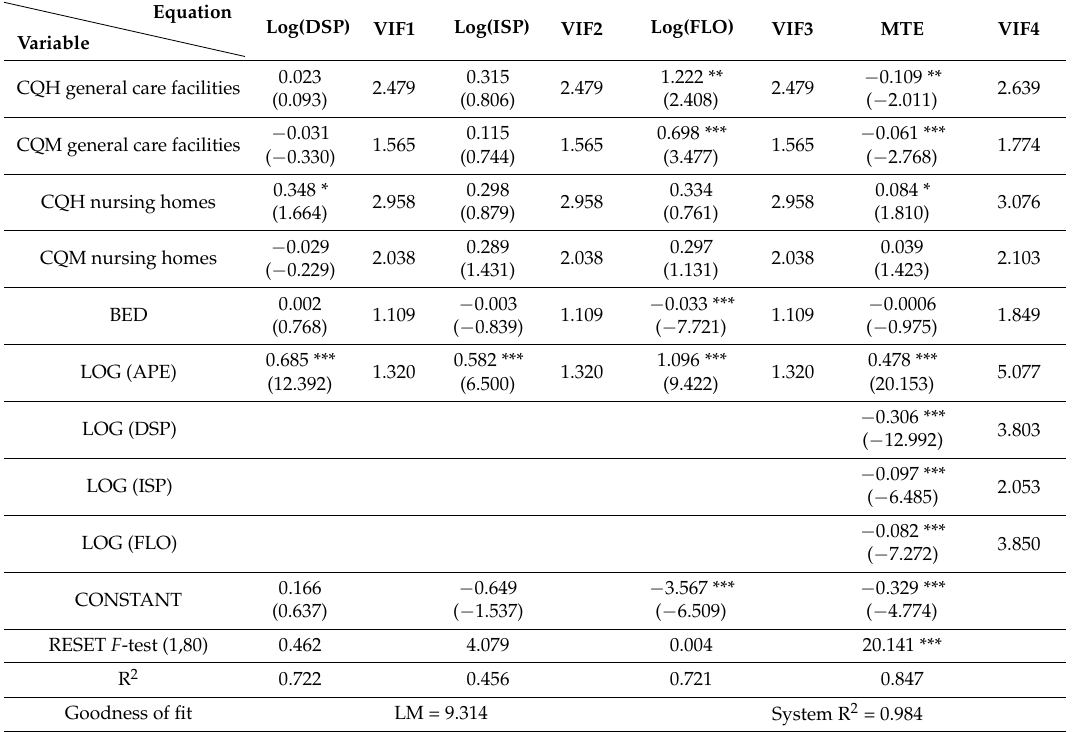
Table 11. Results of the least square regression model.